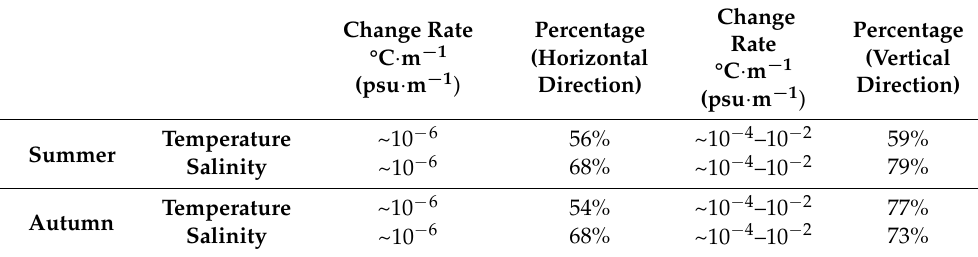
Table 2. Percentages of pairs of points whose change rates are within the specific range for tempera- ture and salinity in horizontal and vertical directions for cruises in